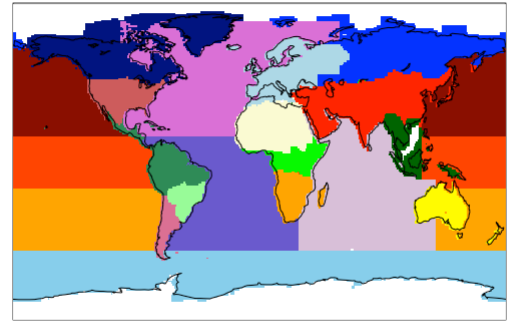
Figure 1. Land and ocean regions. The three land regions: north- ern land, tropical land, and southern land. Northern land com- prises boreal North America (navy blue), Europe (light blue), bo- real Asia (blue), temperate North America (pale red), and tem- perate Asia (red). Tropical land comprises tropical South Ameri- can forests (sea green), northern Africa (sand), equatorial Africa (green), and tropical Asia (dark green). Southern land comprises South American savanna (pale green), temperate South America (violet), southern Africa (orange), and Australia and New Zealand (yellow). Ocean regions comprise North Pacific (dark red), equa- torial Pacific (orange-red), South Pacific (orange), North Atlantic (orchid), equatorial/South Atlantic (slate blue), Indian Ocean (this- tle), Southern Ocean (sky blue), and Arctic Ocean and Antarctica